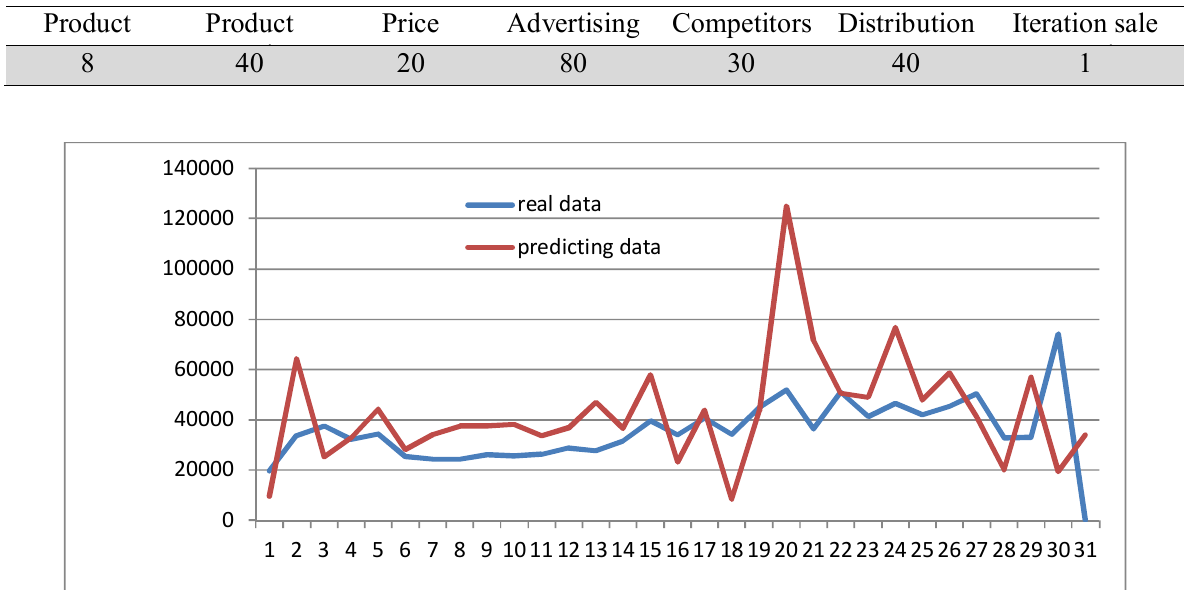
Fig. 2. Comparison of the actual life cycle and predicted life